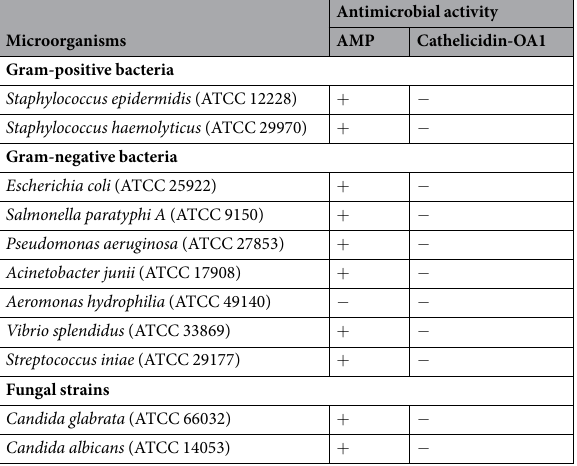
Table 1. Antimicrobial activity of cathelicidin-OA1. ‘ + ’: Indicates antimicrobial activity. ‘ − ’: Indicates no antimicrobial